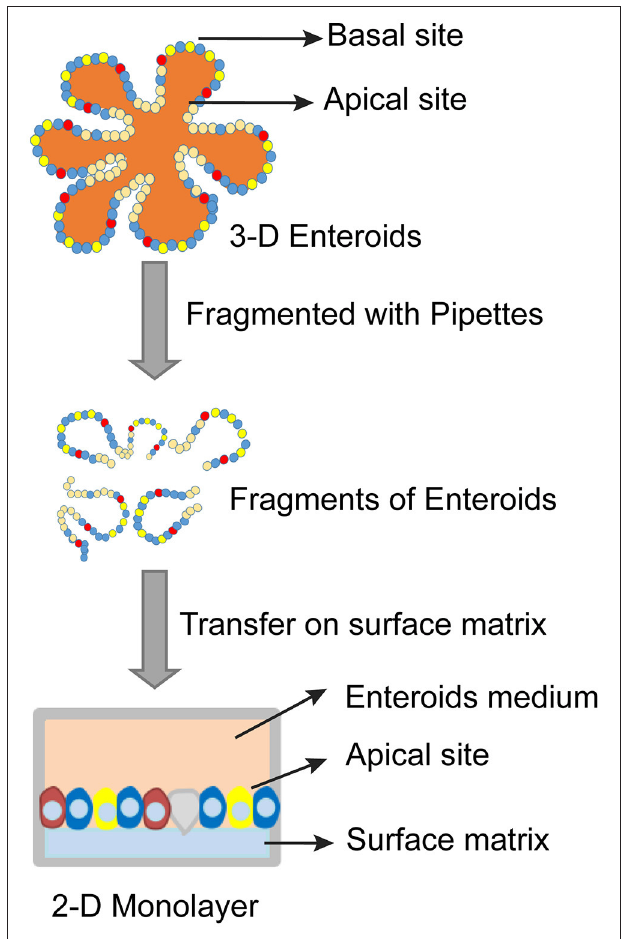
FIGURE 2 | Schematic diagram of establishing 2-D monolayer